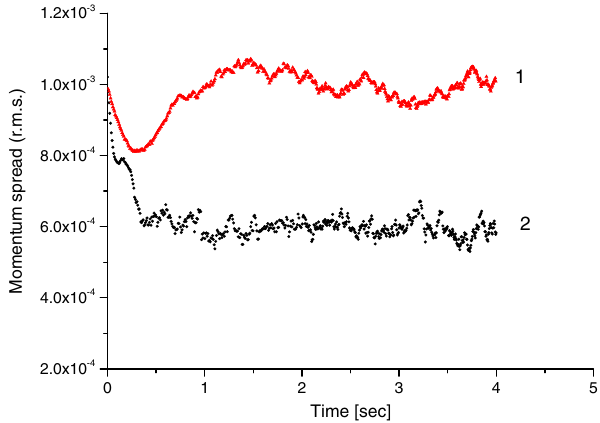
FIG. 17. Evolution of momentum spread (rms) of a high- intensity beam of 20 keV antiprotons cooled by an electron gun with thermocathode (1) and with photocathode (2). The equilibrium momentum spread is ð (cid:7)p=p Þ eq rms ¼ 10 (cid:3) 3 and ¼ 6 (cid:6) 10 (cid:3) 4 , ð (cid:7)p=p Þ eq rms